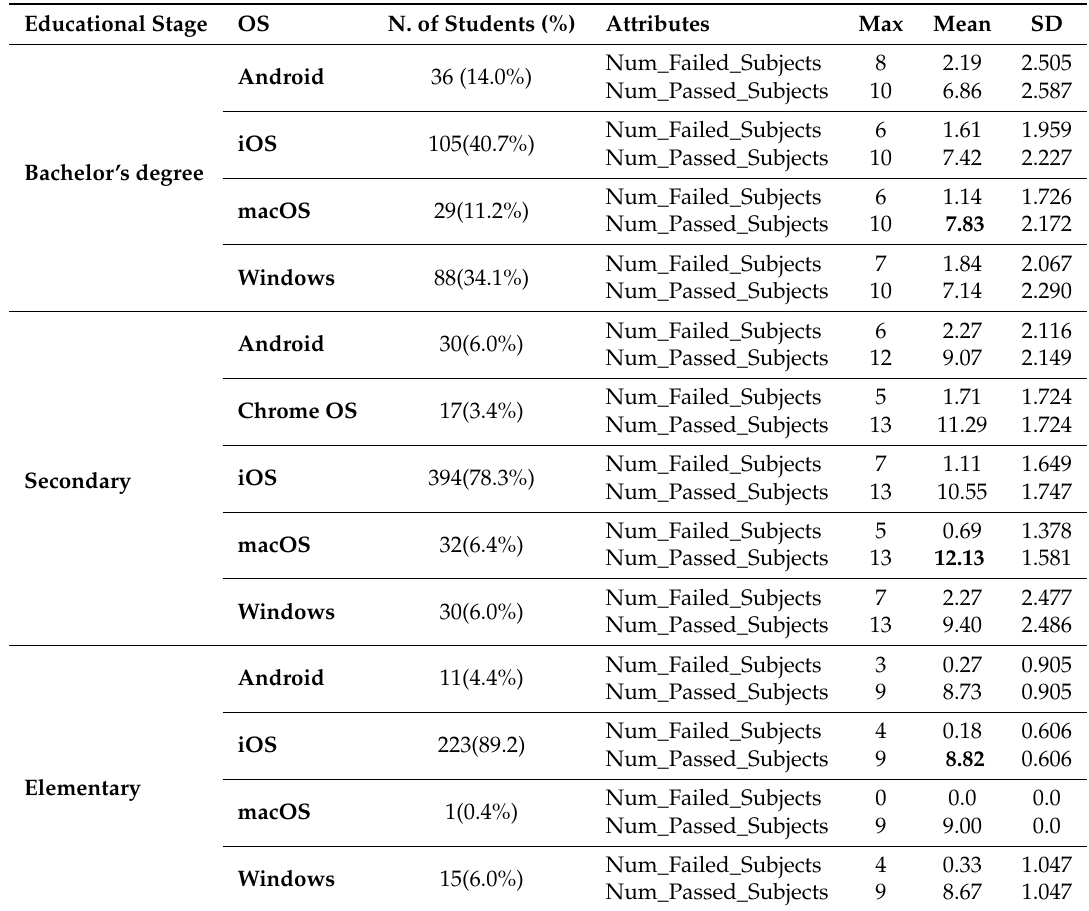
Table 6. Number of students, percentage, maximum, mean and standard deviation of number of passed and failed subjects for students who have ever logged in the LMS according to the educational stage and operating system used for the connection. The best results considering the mean number of subjects passed for each educational stageare highlighted in bold Educational Stage N. of Students